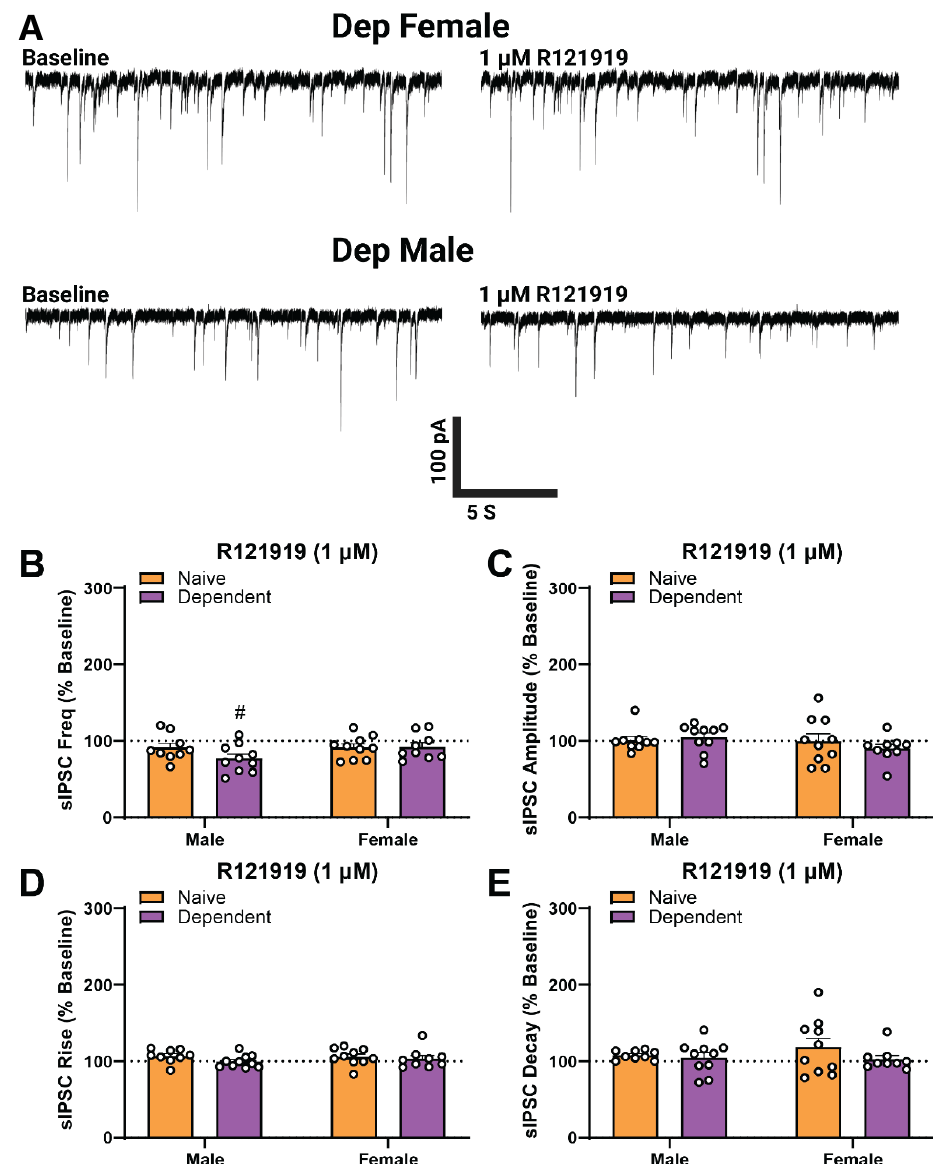
Figure 6. Alcohol-dependent males, but not females, have a basal CRF 1 -mediated tone in the central amygdala (CeA) . ( A ) Representative GABA A -mediated sIPSCs from CeA neurons of dependent female ( upper ) and male ( lower ) rats at baseline ( left ) and during acute application of R121919 (1 µ M; right ). There was no main effect of Sex or Alcohol Exposure and no interaction effect of R121919 on sIPSC frequency ( B ), amplitude ( C ), rise time ( D ), or decay time ( E ). Changes from baseline sIPSC properties were assessed using one-sample t-tests where # denotes p < 0.05. Group differences in the sIPSC responses to R121919 were assessed using two-way ANOVA test but were not observed. n = 9–10 neurons per group; N = 5–6 animals per group; bars represent Mean ± SEM.